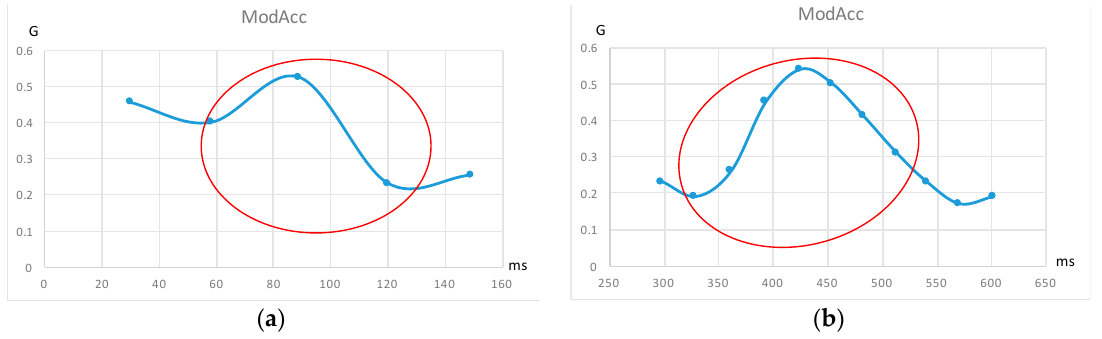
Figure 17. Local maximum of level 1 ( a ); and Local maximum of level 3 ( b ). Vertical units are fractions of g (9.8 m/s 2 ).